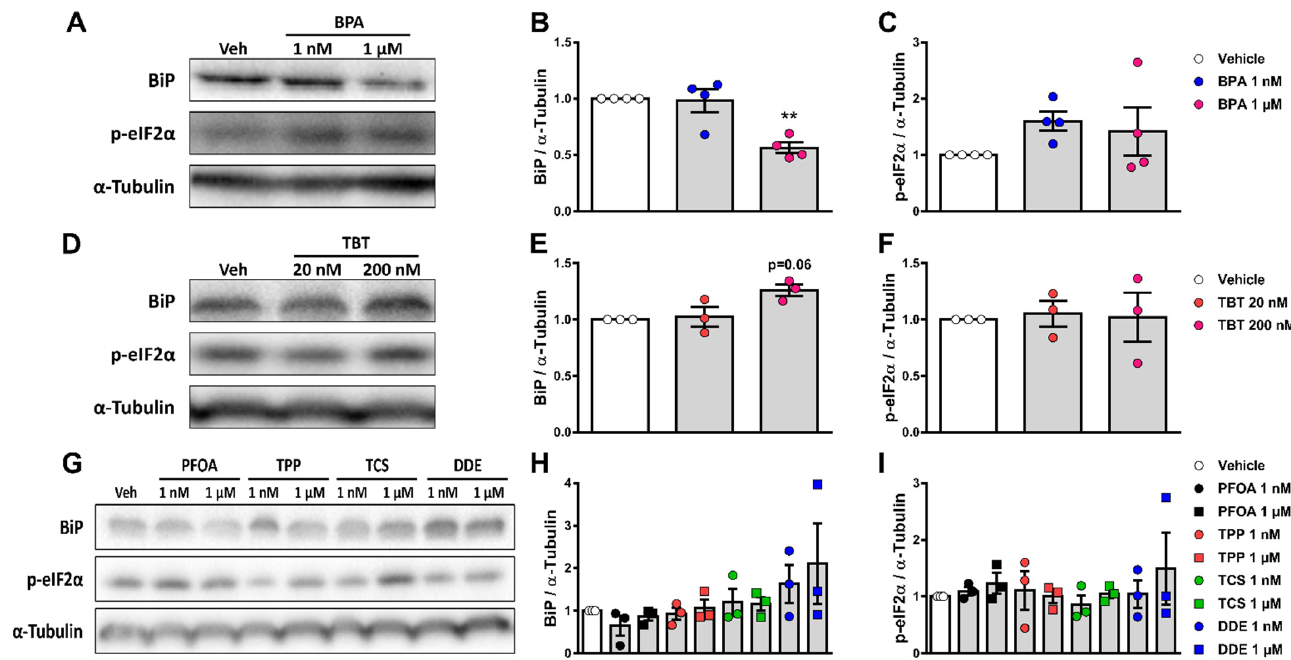
Figure 4. Expression of ER stress markers upon MDC exposure. α TC1-9 cells were treated with vehicle (DMSO) or different doses of BPA ( A – C ), TBT ( D – F ), PFOA, TPP, TCS, or DDE ( G – I ) for 24 h. Protein expression was measured by Western blot. Representative images of three independent experiments are shown ( A , D , G ) and densitometry results are presented for BiP ( B , E , H ) and p-eIF2 α ( C , F , I ). Data are shown as means ± SEM (n = 3–4 independent experiments, where each dot represents an independent experiment). ** p ≤ 0.01 vs. vehicle. MDCs vs. vehicle by one-way ANOVA.